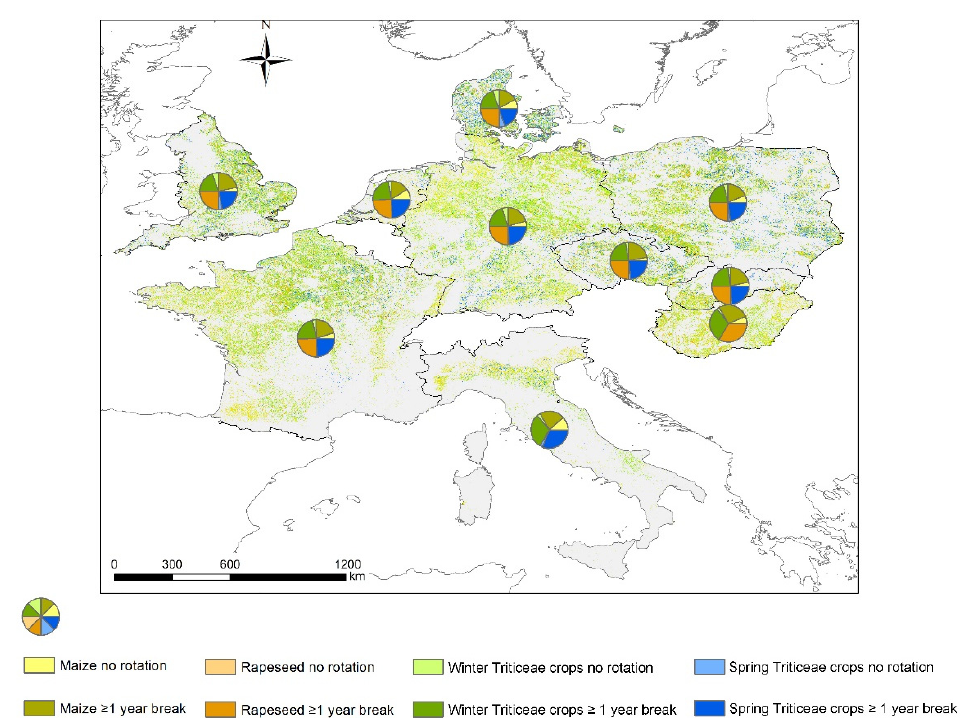
Figure 8. Proportions of areas that are grown in rotation intervals of 0 and ≥ 1-year break across the 10 European Union (EU) countries.